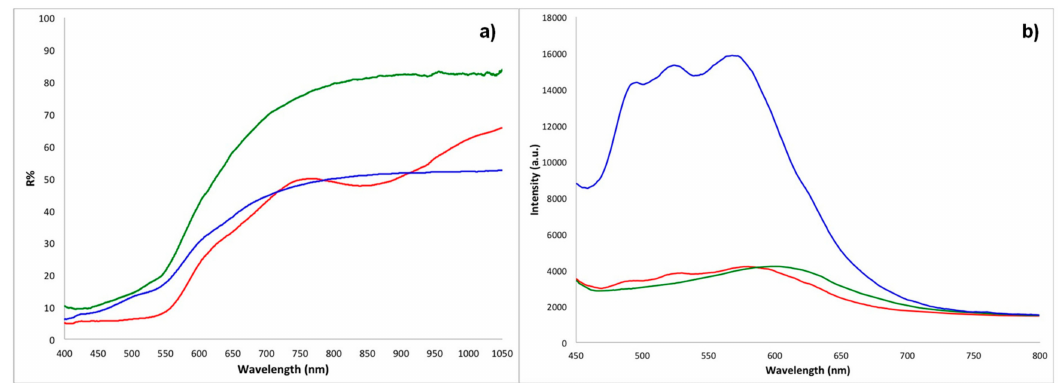
Figure 2. ( a ) Representative fibre optic reflectance spectroscopy (FORS) spectra (R = reflectance) and ( b ) representative portable fluorimetry (p-FL) spectra for textiles dyed with ochre (red), madder (green), and sa ffl ower (blue). FORS spectra: ME7, BM4, and ME3. p-FL spectra: ME7, ME2, and